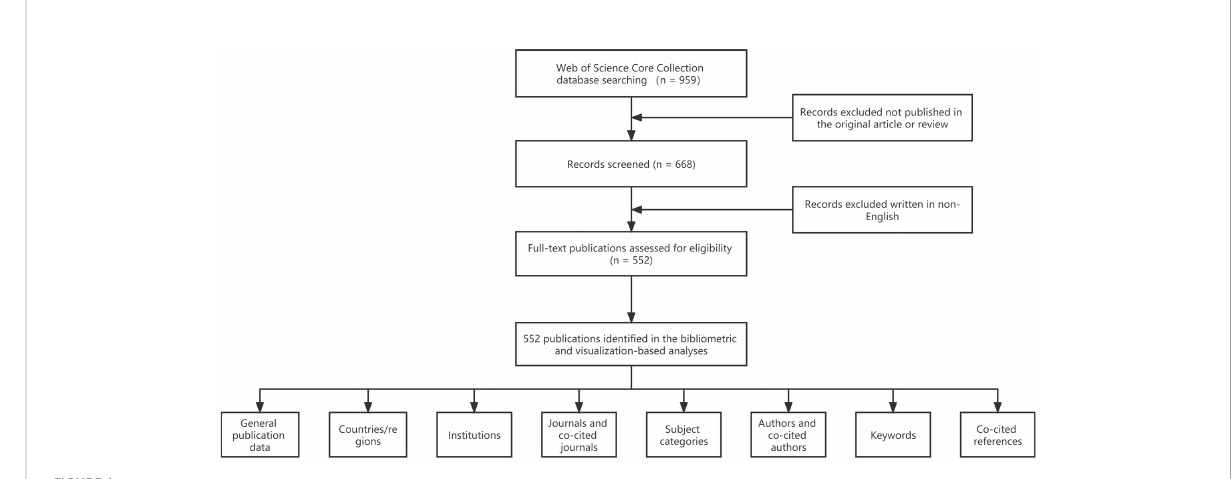
FIGURE 1 Flow Diagram of detailed retrieval process and analysis